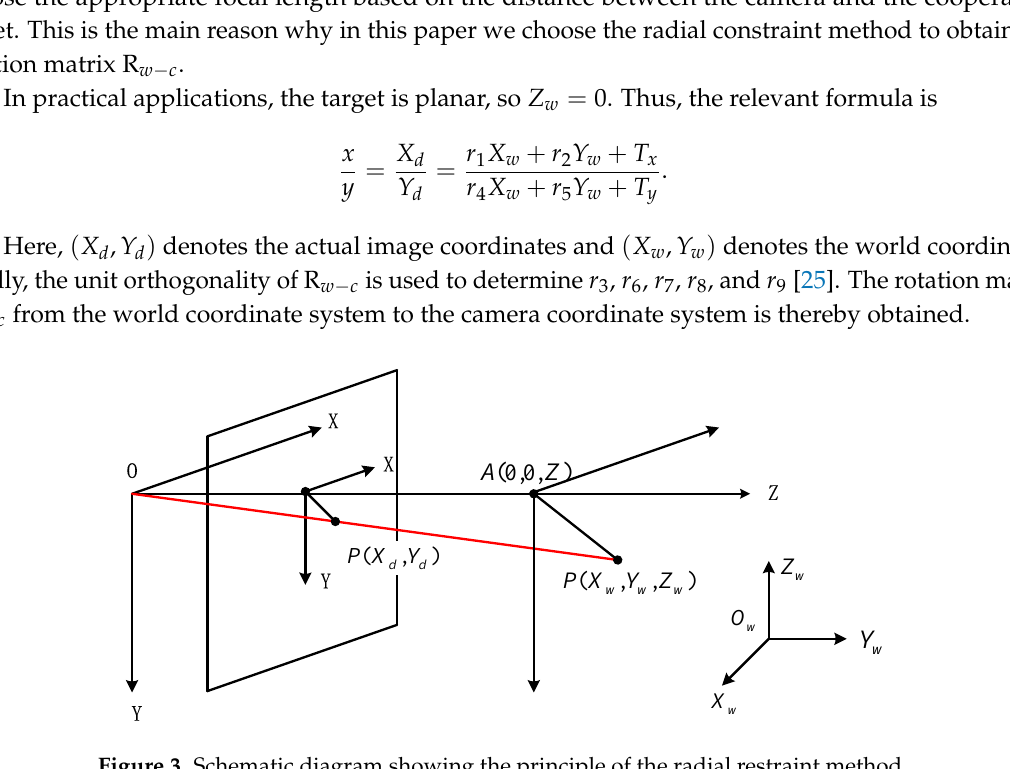
Figure 3. Schematic diagram showing the principle of the radial restraint